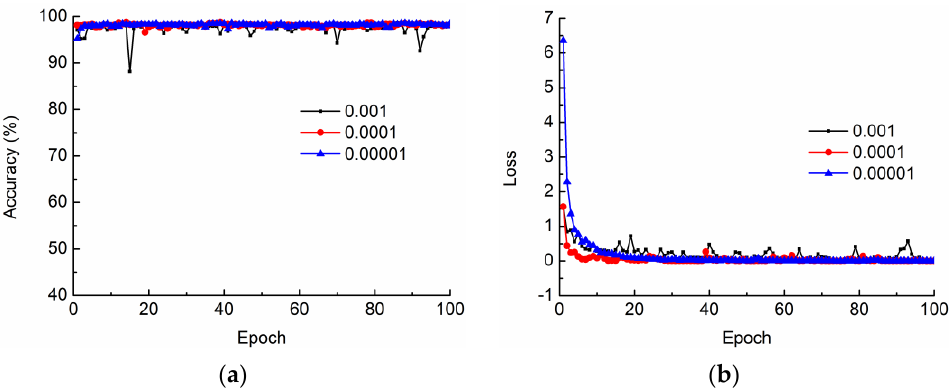
Figure 3. Validation results of different learning rates using Adam: ( a ) Accuracy; ( b ) loss value.